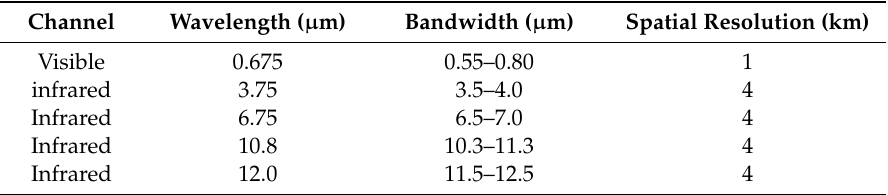
Table 2. Band characteristics of the Communication, Ocean and Meteorological Satellite (COMS).